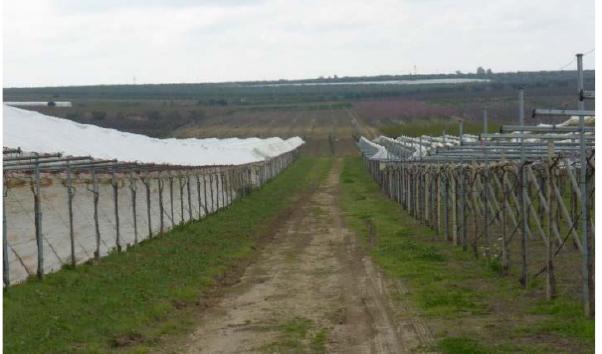
Figure 1. Adjacent vineyards protected with plastic sheets (left), uncovered vineyard (right) at the beginning of the second year of trial.